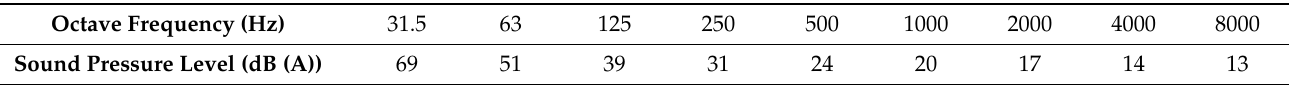
Table 2. The sound pressure levels of the NR -20 curve in the corresponding octave frequency bands. Octave Frequency